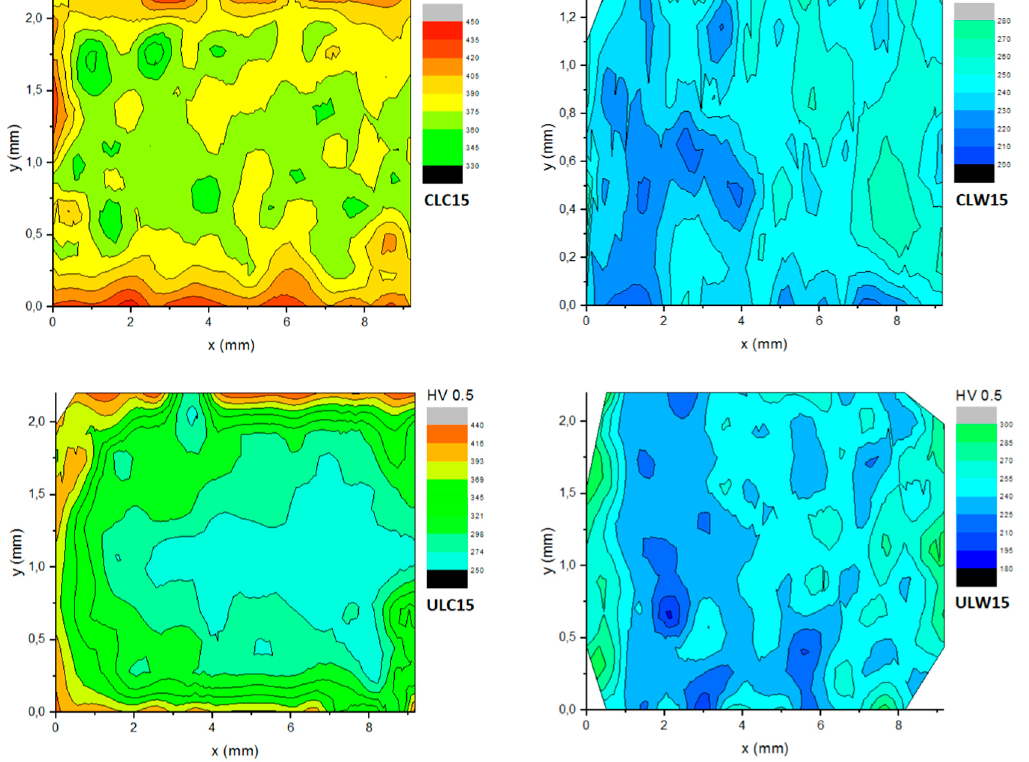
Figure 9. 2D microhardness maps of the CLC15, CLW15, ULC15 and ULW15 samples, obtained on polished cross sections through the center of the samples. The left edges of the maps correspond to the sample circumference, right edges to the central axis.